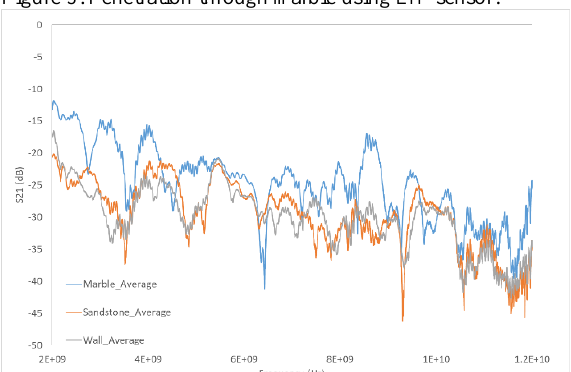
Figure 3. Penetration through marble using EM sensor.